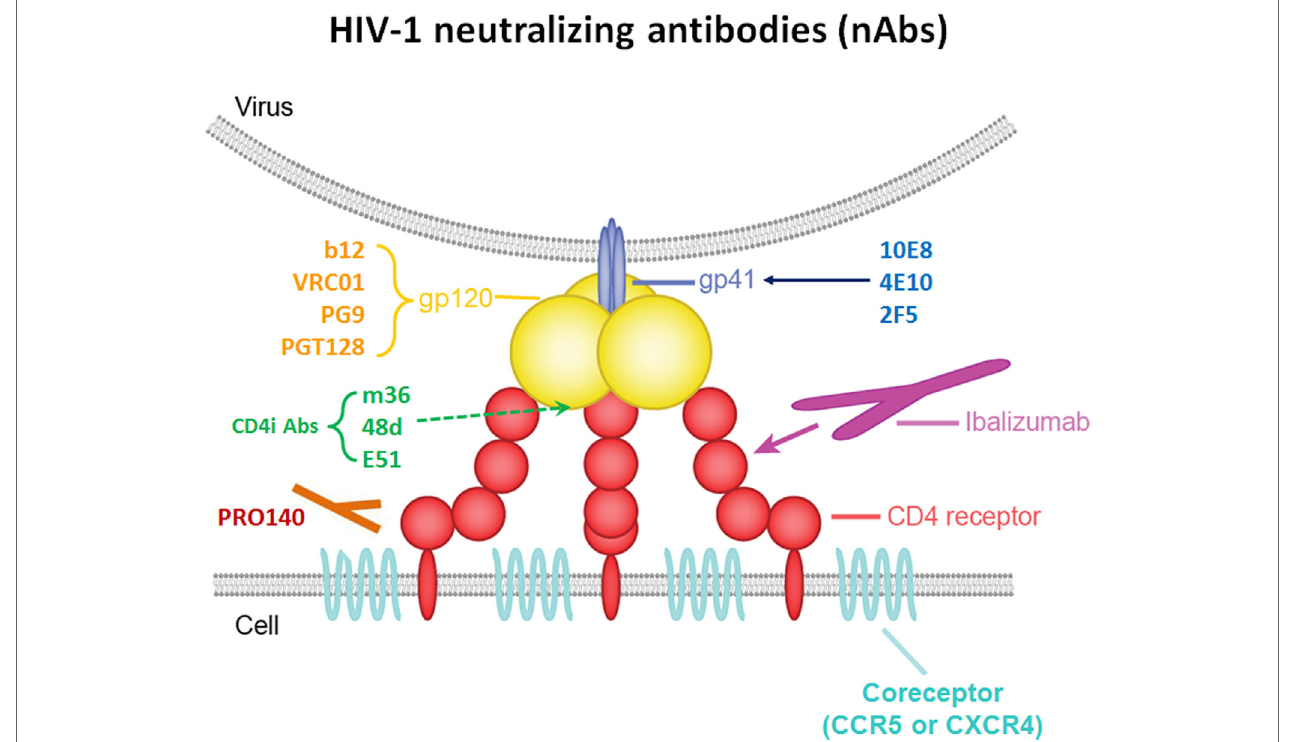
FiGURe 1 | Schematic interactions between Hiv-1 and a T cell in the presence of broadly neutralizing antibodies (bNAbs)